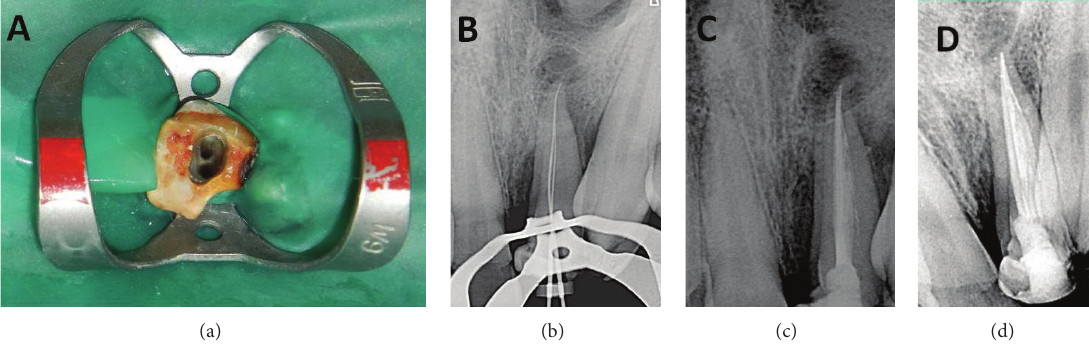
Figure 3: (a) Clinical picture showing two distinct canal openings: one labial and one palatal in the central incisor. (b) Radiographic determination of working length. (c) Postoperative periapical radiograph demonstrating completed nonsurgical root canal therapy. (d) Postoperative periapical radiograph with angulated